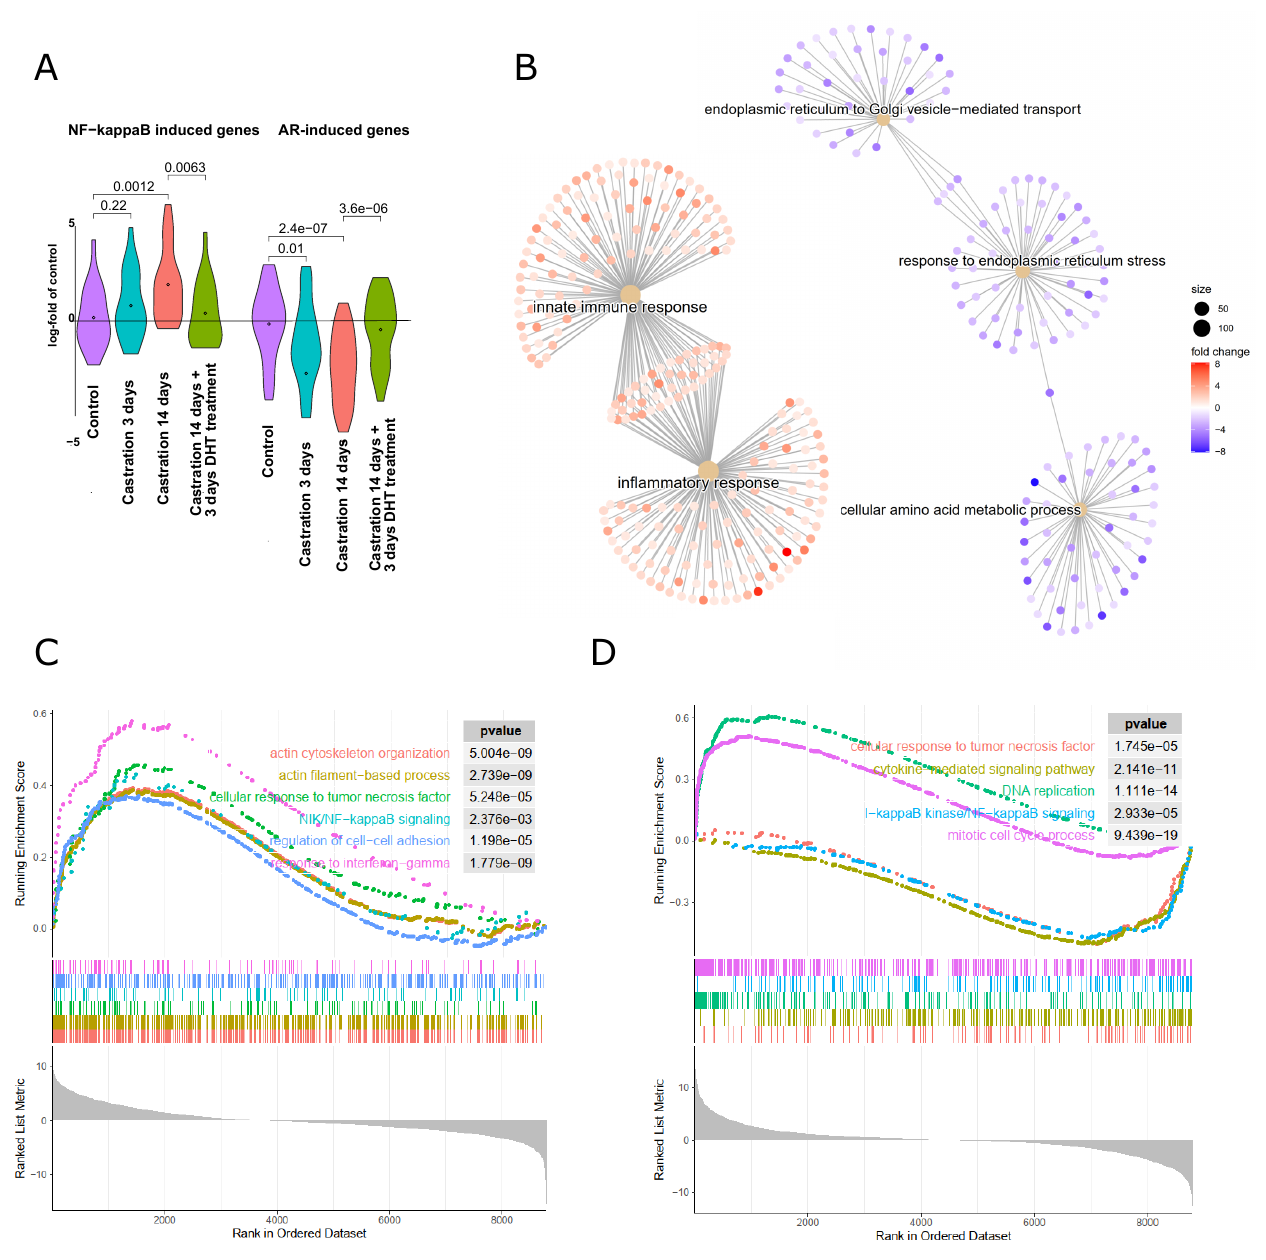
Figure 6. Gene expression changes in the mouse model of antiandrogen treatment via castration. ( A ) Gene expression data from prostates derived from mice that were castrated to eliminate androgen signaling, or sham-operated (control) followed by RNA extraction after 3 days or 14 days as indicated. One cohort was treated with dihydrotestosterone for 3 days, 14 days after castration to reactivate androgen signaling (castr. 14 d + DHT 3 d, dataset GEO GSE5901, [28]). Androgen-induced genes [46] and NF- κ B target genes (Supplementary Table S1) are shown as violin plots in comparison to control prostates. ( B ) Comparison of biological processes in prostates of mice 3 days after castration as com- pared to sham-operated mice: gene ontology analysis of upregulated (red nodes) or downregulated (blue nodes) processes. ( C ) Gene set enrichment analysis (GSEA) of mice 14 days after castration as compared to sham-operated control mice. Inflammatory signaling pathways, cell adhesion, and actin-based processes are upregulated. ( D ) GSEA after readdition of testosterone to castrated mice as compared to the castrated mice: mitotic cell cycle and DNA replication are upregulated and NF- κ B signaling processes (response to TNF α , cytokine-mediated signaling, and IKK/NF- κ B signaling) are